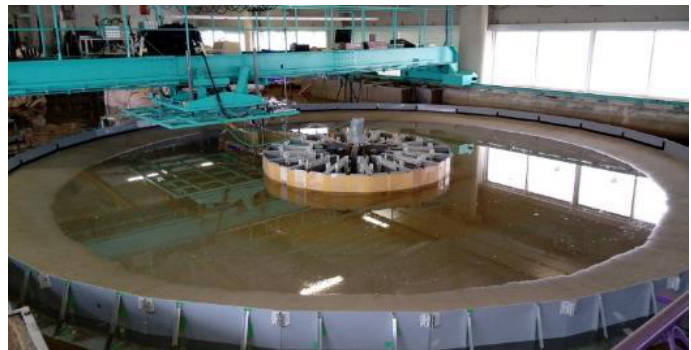
Figure 1. Circular wave-making water tank.